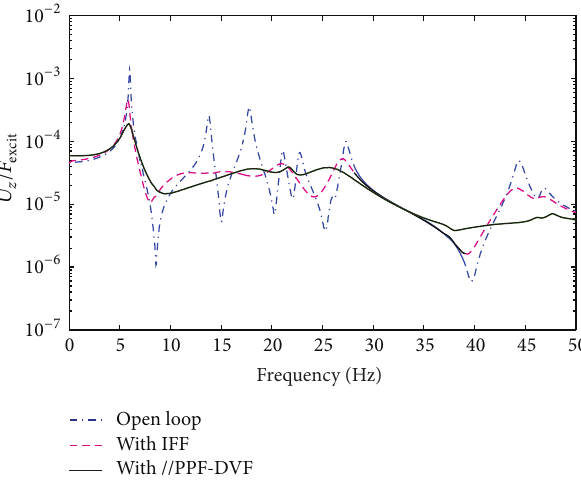
Figure 5: Maximum damping ratio as a function of mode number for different active control strategies.